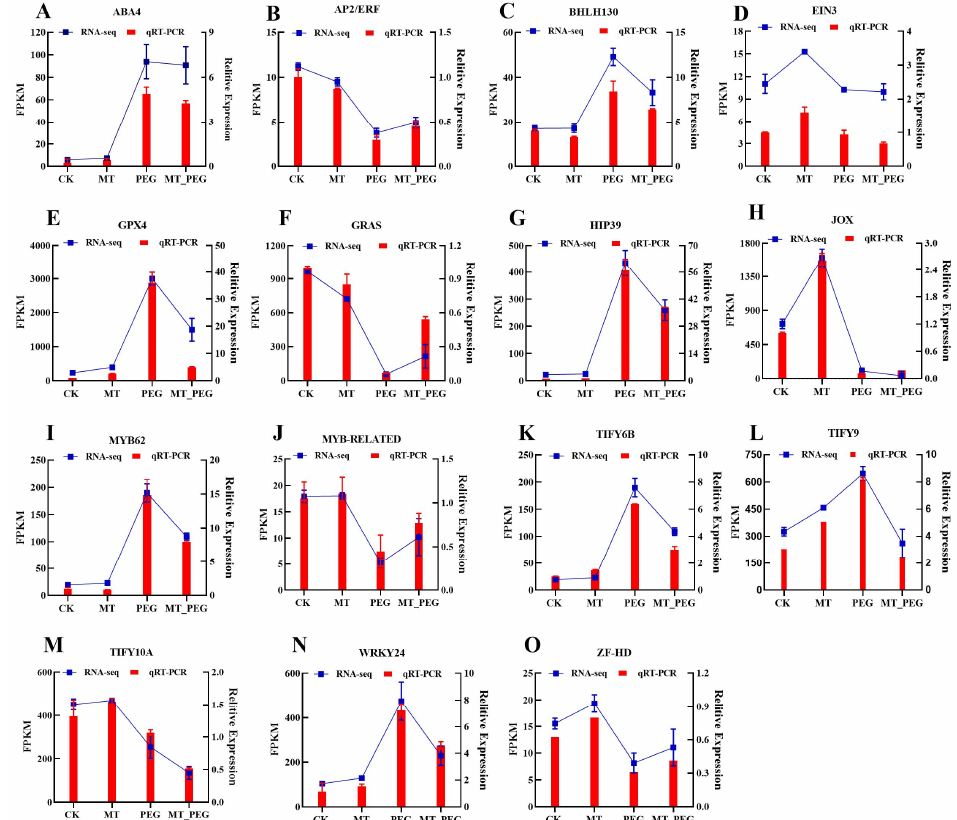
Figure 8. Accompanied by RNA-seq data, verification of phytohormones and transcription-factor-related DEGs by RT-qPCR. ( A – D ) Relative expression and RNA-seq data of genes related to ABA4 , AP2/ERF , BHLH130, and EIN3 . ( E – H ) Relative expression and RNA-seq data of two genes related to GPX4 , GRAS , HIP39, and JOX1 . ( I – L ) Relative expression and RNA-seq data of genes related to MYB62 , MYB-RELATED , TIFY6B, and TIFY9 . ( M – O ) Relative expression and RNA-seq data of genes related to TIFY10A , WRKY24, and ZF-HD . Error bars show the standard error between three biological replicates performed (n = 3).